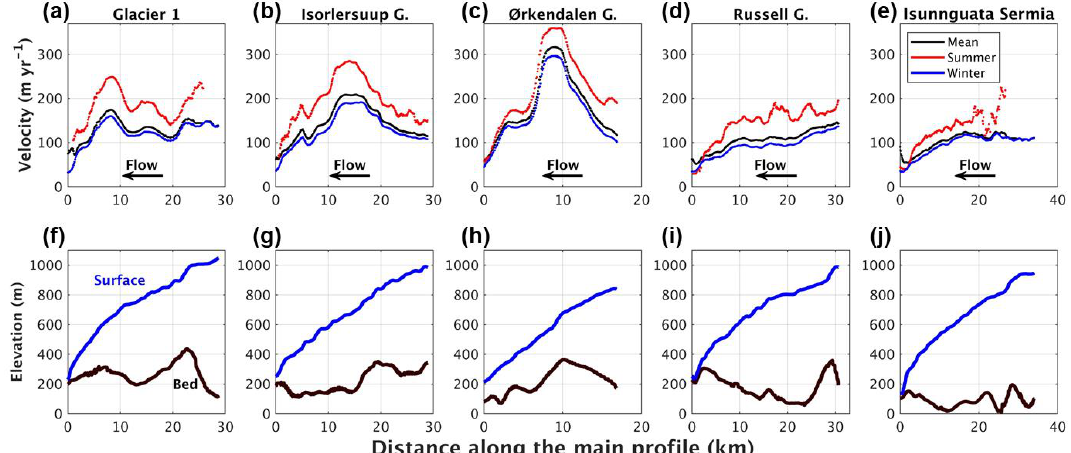
Figure 2. Mean summer and winter ice velocity ( a – e ) and geometry ( f – j ) along central profiles of five glaciers in west-central Greenland (see Figure 1 for glacier locations) in 2016 and 2017. Surface and bed elevations are from the Greenland Ice Mapping Project digital elevation model (GIMP-DEM) [54] and IceBridge BedMachine Greenland, Version 3 [58], respectively.